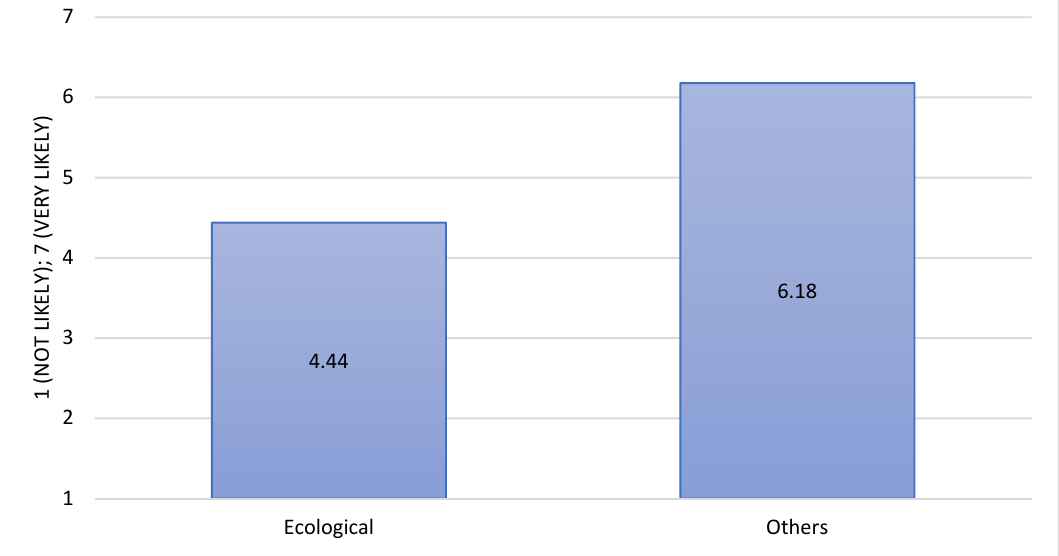
Figure 10. Probability of adopting agroecological practices in the future depending on the size of the farm.